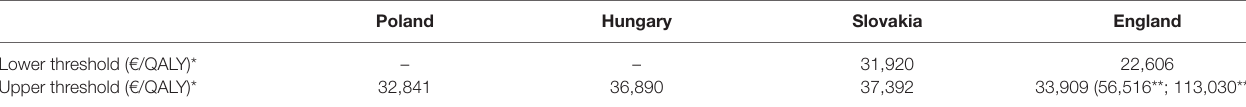
TABLE 3 | Cost-effectiveness thresholds in Poland, Hungary, Slovakia, and England in